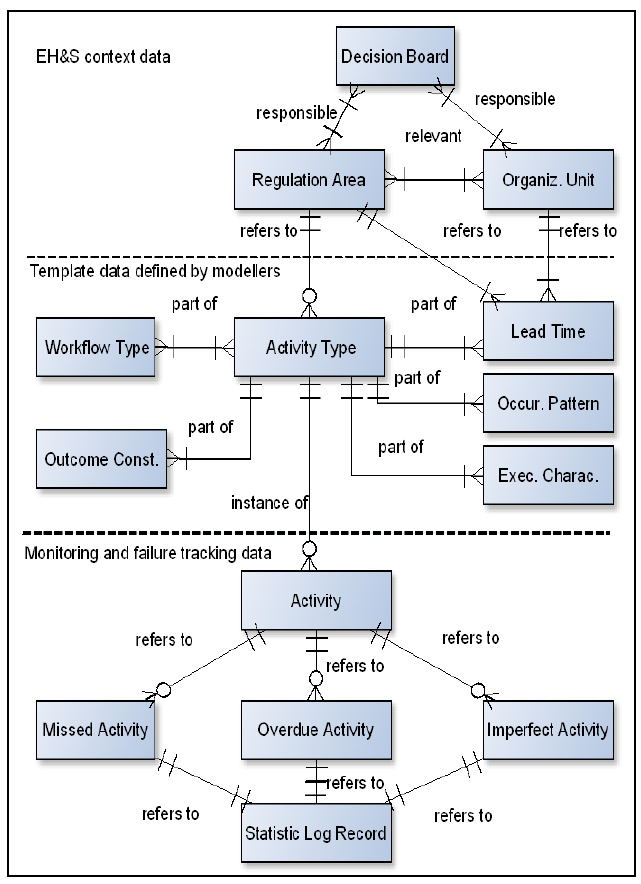
Fig. 1. Proposed workflow meta data